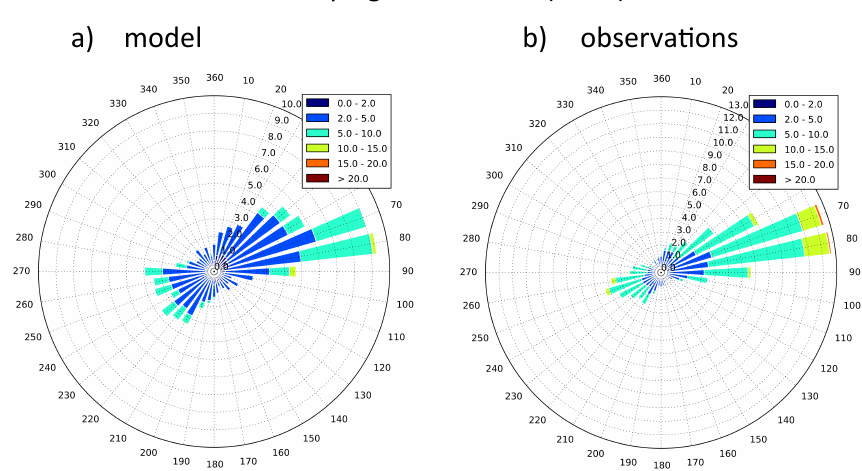
Figure 11. As in Fig. 5, but for Deadhorse, AK.